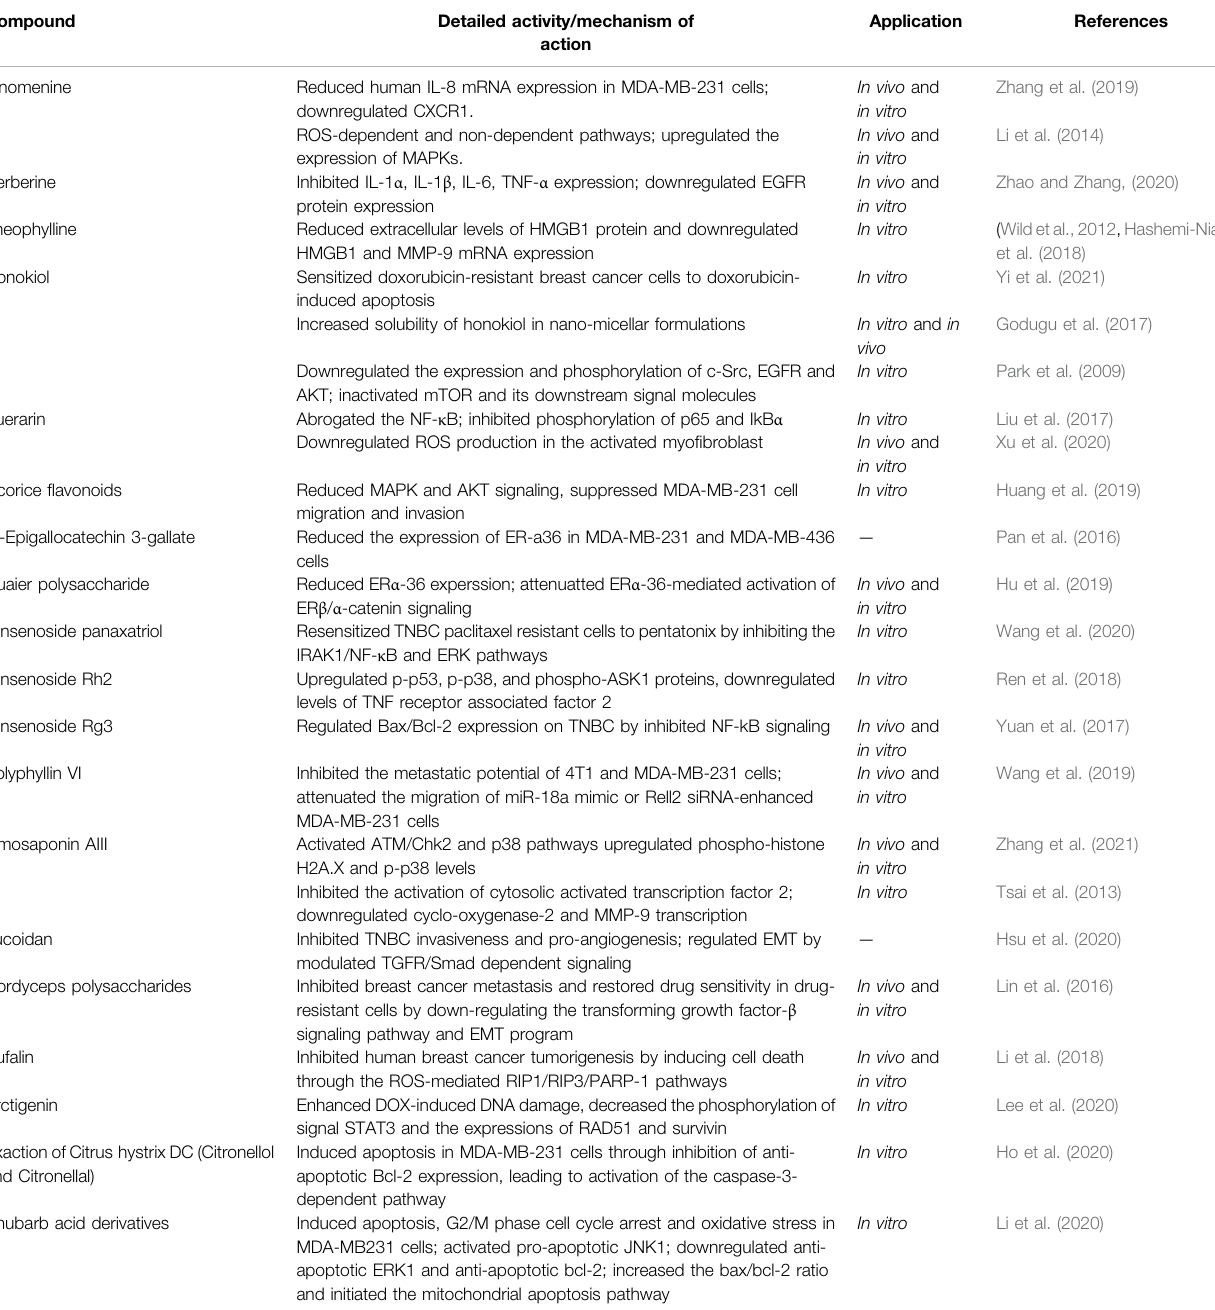
TABLE 1 | Role of TCM in